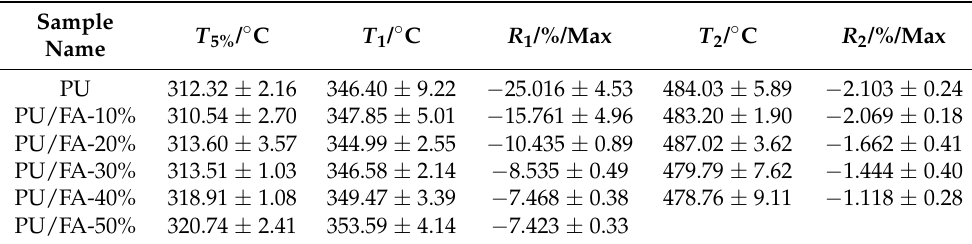
Table 2. The following thermal stability parameters are calculated by the TG/DTG curve for the PU and PU/FA composites.